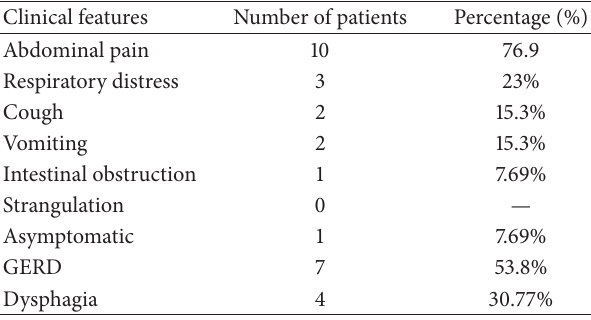
Table 1: Demographic profile of patients. Table 2: Clinical manifestation.